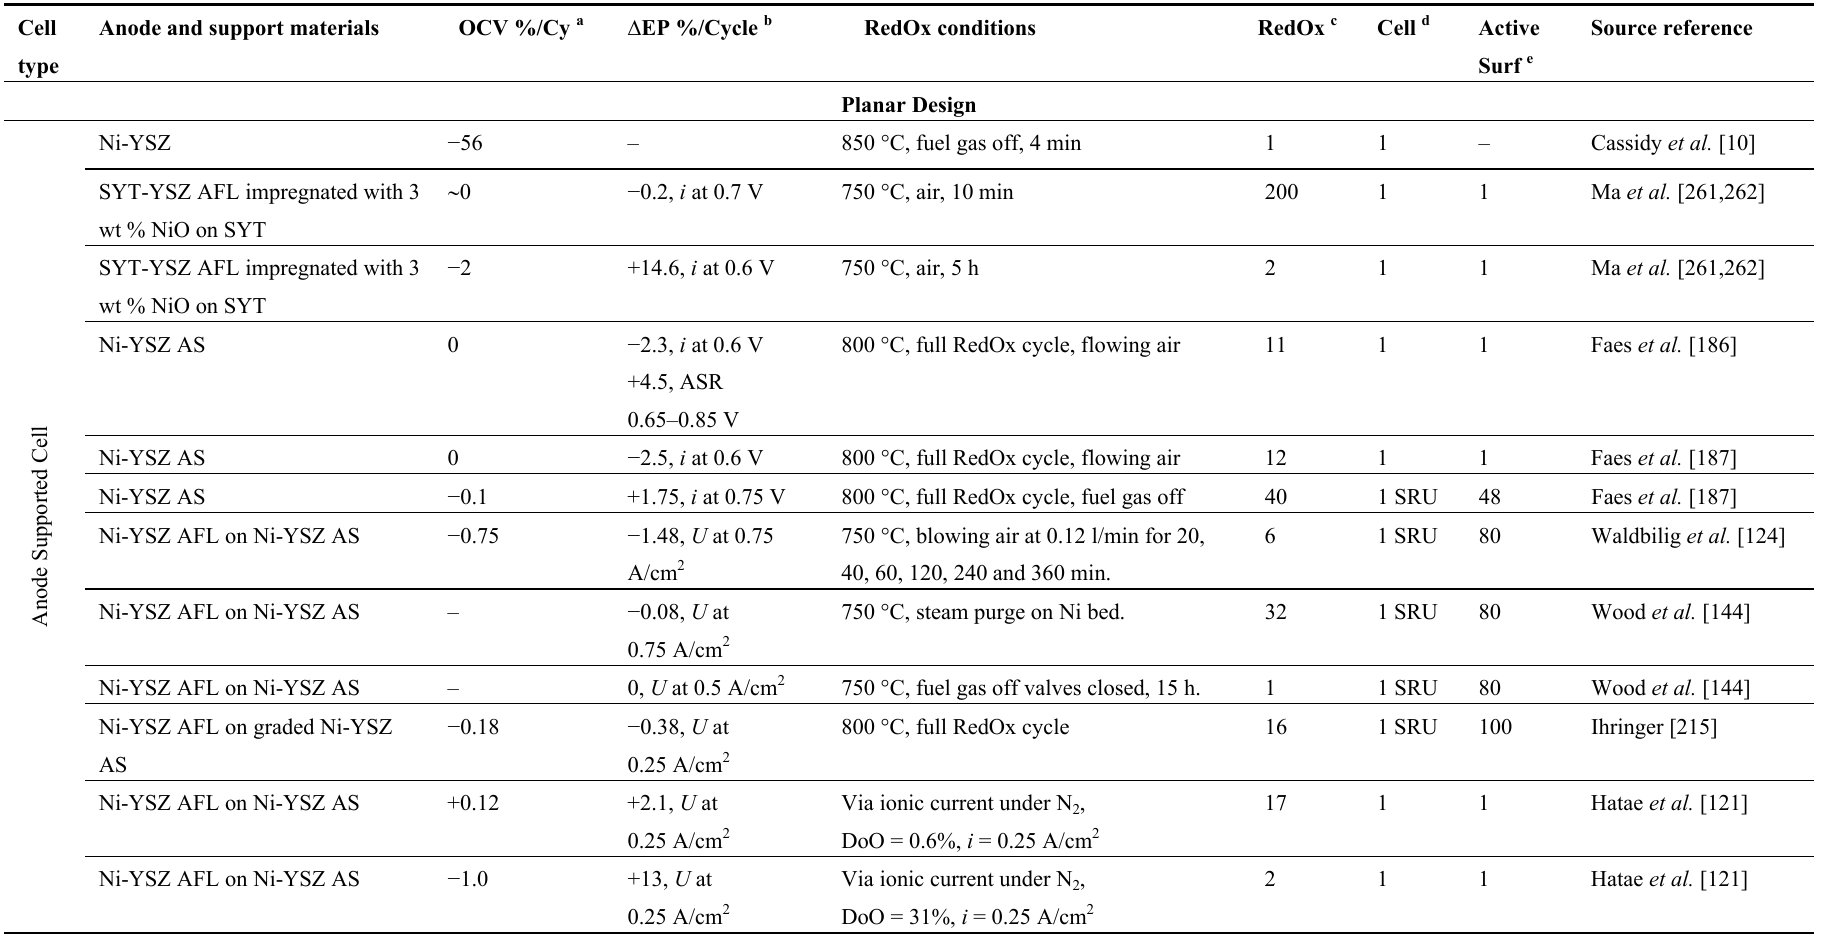
Table A1. Summary of RedOx cycle effect on open circuit voltage (OCV) and electrochemical performance variation ( ∆